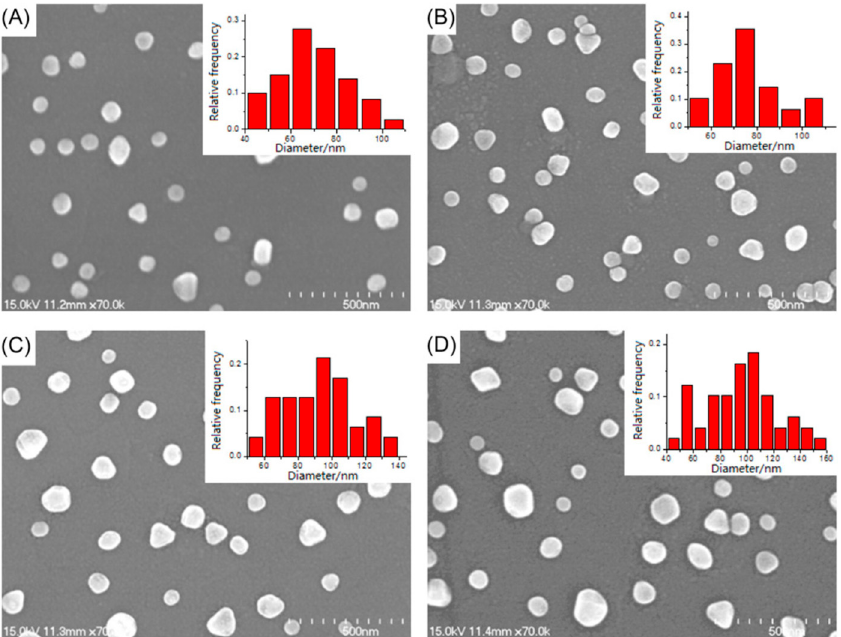
Figure 11. SEM images of AuNPs deposited on indium tin oxide (ITO) glass after annealing at 600 °C for ( A ) 0.5 ( B ) 2.0 ( C ) 4.0 and ( D )10.0 h. Inset: size distribution (reproduced from Feng et al. [51], Open Access paper).